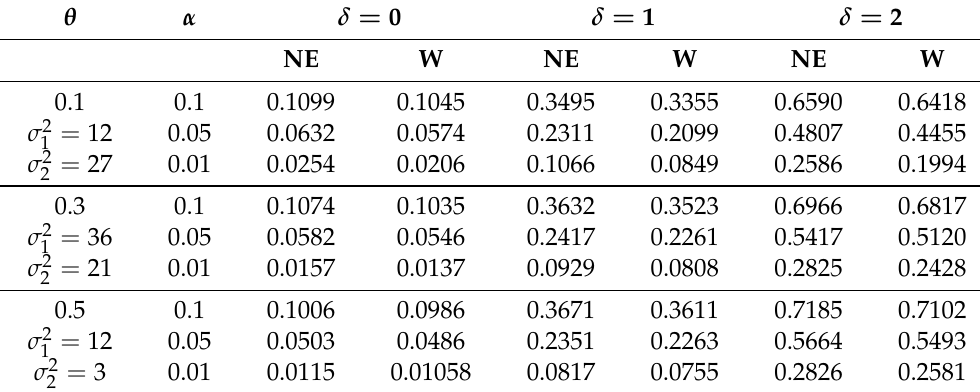
Table 6. Power values for ( n 1 , n 2 ) = ( 12,3 )